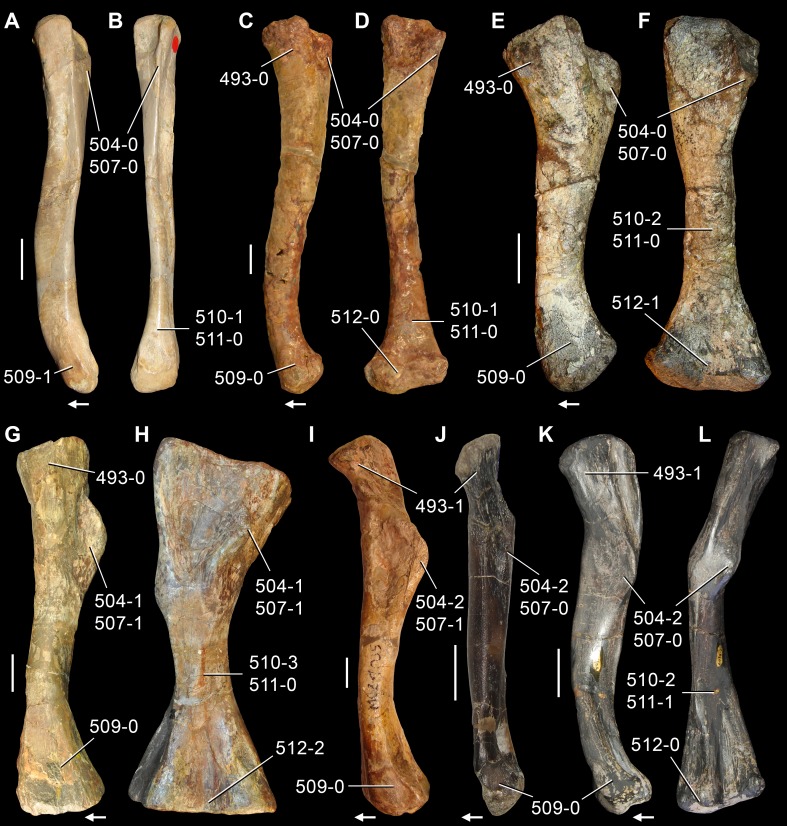
Femora of Triassic archosauromorphs in (A, C, E, G, I–K) medial and (B, D, F, H, L) posterior/ventral views.(A, B) Left element of Tanystropheus longobardicus (SMNS unnumbered); (C; D) left element of Prolacerta broomi (BP/1/2676); (E, F) left element of Proterosuchus fergusi (SAM-PK-K140); (G, H) left element of Erythrosuchus africanus (NHMUK PV R3592); (I) right element of Chanaresuchus bonapartei (MCZ 4035); (J) right element of Jaxtasuchus salomoni (SMNS 91002); and (K, L) left element of Aetosauroides scagliai (PVL 2073, [K] mirrored). Numbers indicate character-states scored in the data matrix and the arrows indicate anterior/dorsal direction. Scale bars equal 2 cm in (A, B, E, F, K, L), 5 mm in (C, D), 5 cm in (G, H), and 1 cm in (I, J).